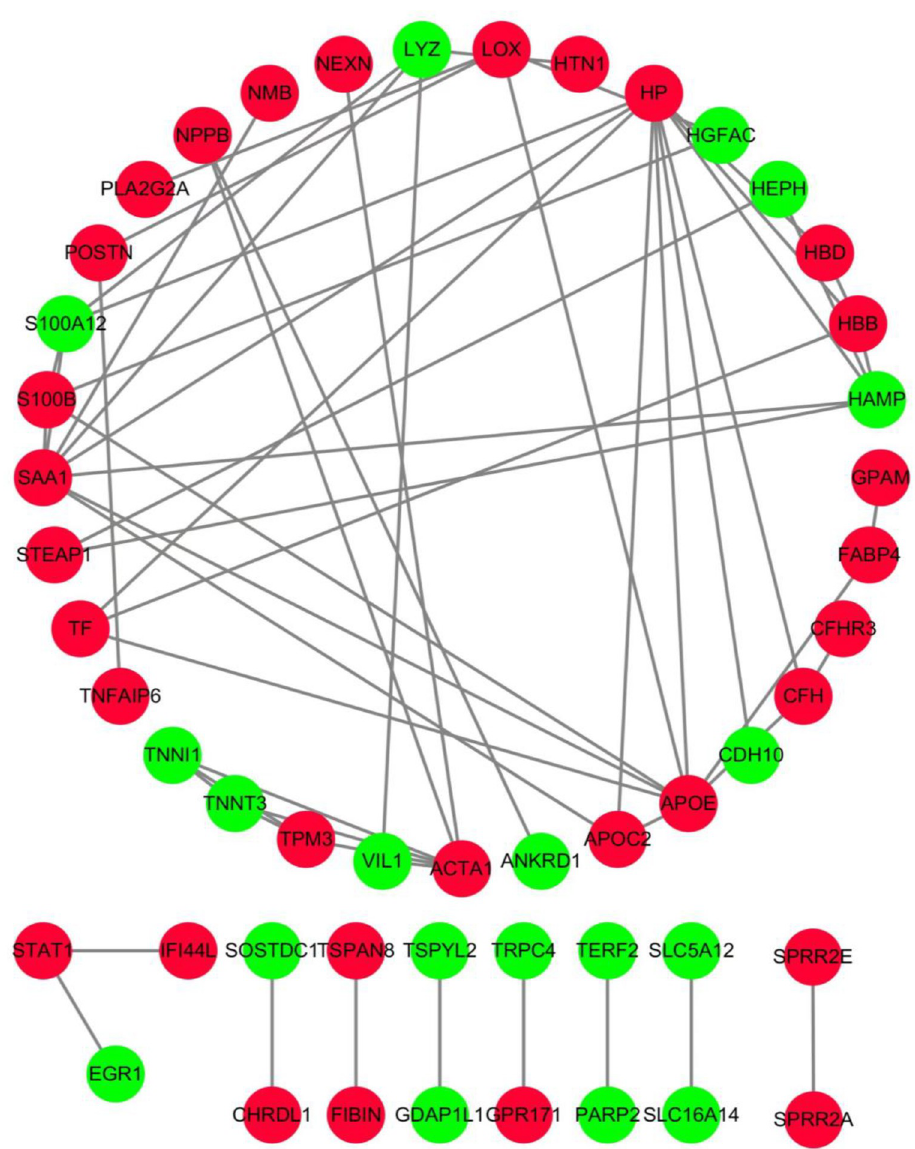
Fig 3. Construction of protein–protein interaction (PPI) network for upregulated and downregulated differential mRNAs. Red nodes, upregulated mRNAs; green nodes, downregulated mRNAs.